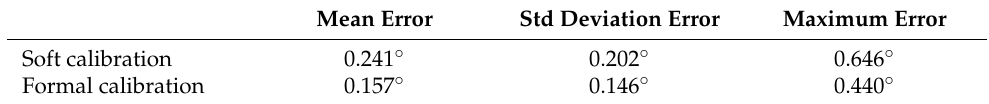
Table 4. Errors in the calculation of the rotation angle using emitters 1 and